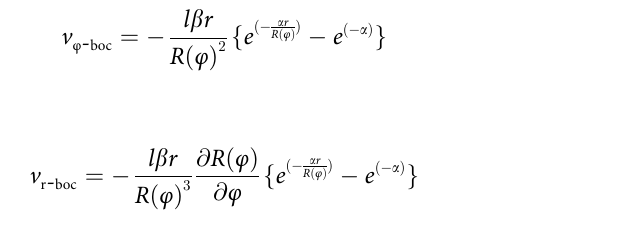
is the velocity in the vertical direction. y